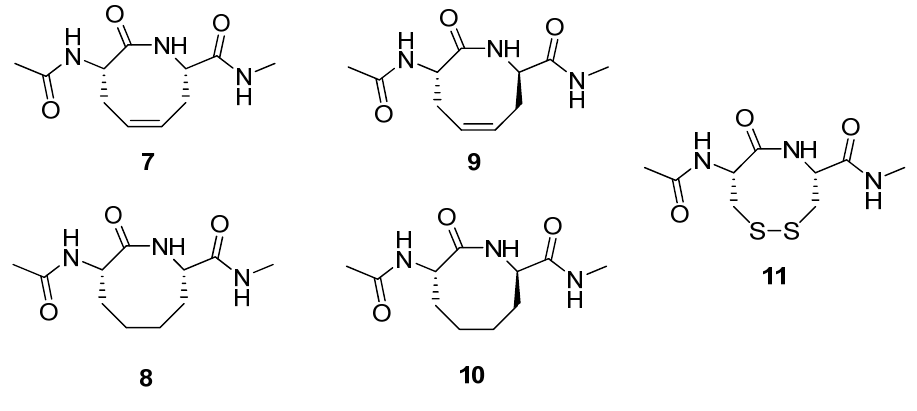
Figure 3. The (2 S ,7 R )-alkene 9 adopts a type VIa β -turn conformation both in the crystal state and in aqueous solution.